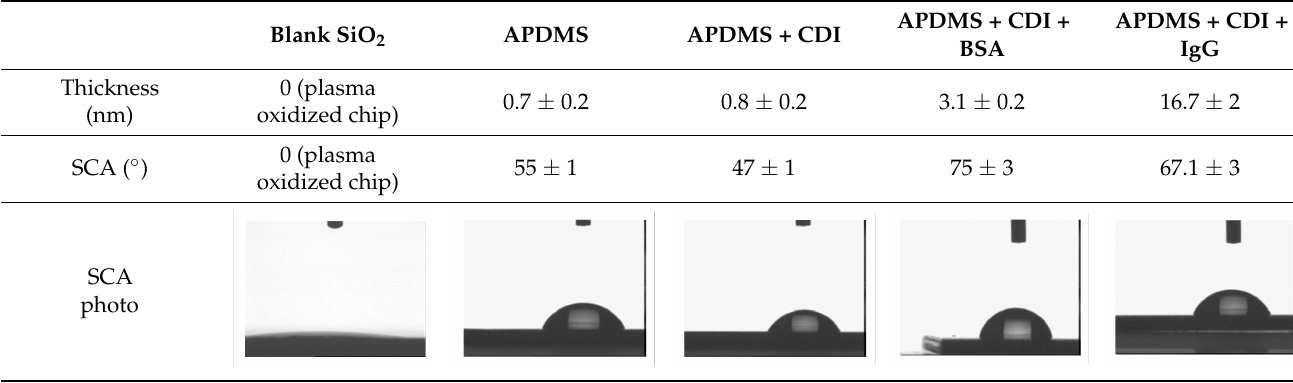
Table 2. Ellipsometry and SCA data from the different biofunctionalization